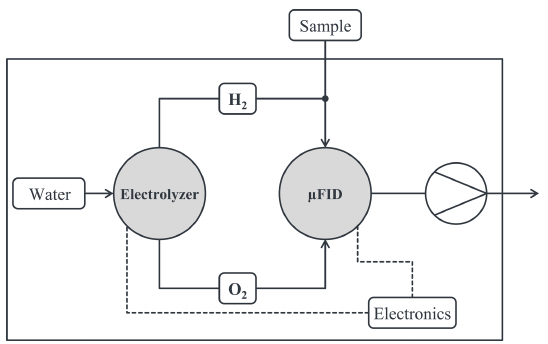
Figure 3. Schematic drawing of the device concept of the au- tonomous